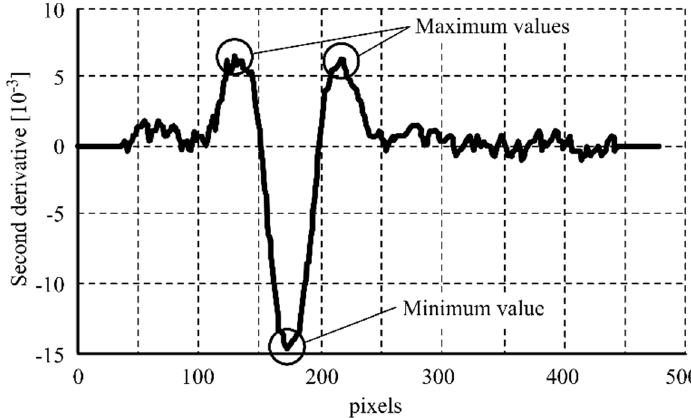
Figure 6. Second derivative of the one-pixel width laser profile after the welding operation.